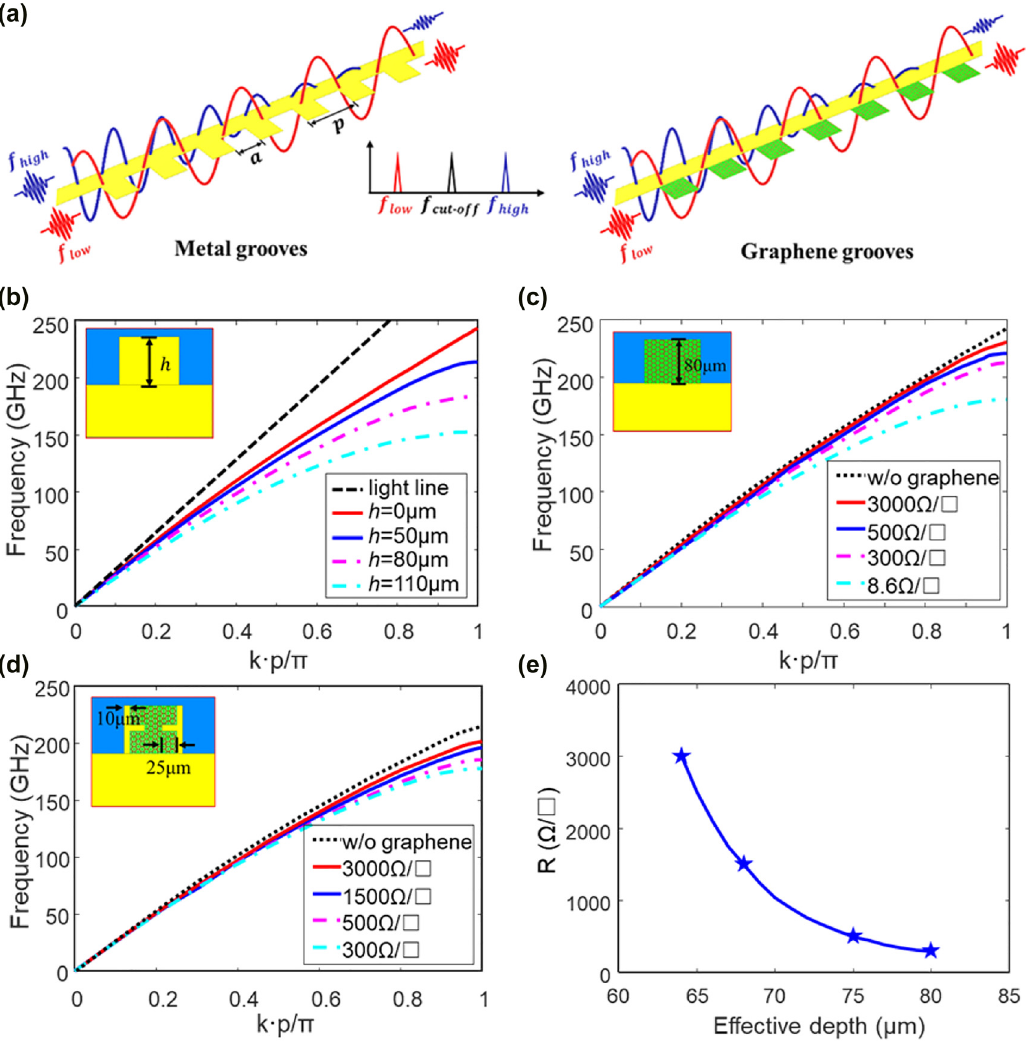
Figure 1: THz SPPs and their dispersion curves. (a) Metal SPP and metal–graphene hybrid SPP structures ( p = 0.21 mm, a = 0.1 mm). Dispersion curves of (b) metal grooves with various depth, (c) graphene grooves at various sheet resistances for graphene, and (d) graphene grooves with metal tips at various sheet resistances for graphene ( h = 80 μ m). The insets show the unit cell of THz SPPs. (e) Correspondence of resistance and effective depth of graphene